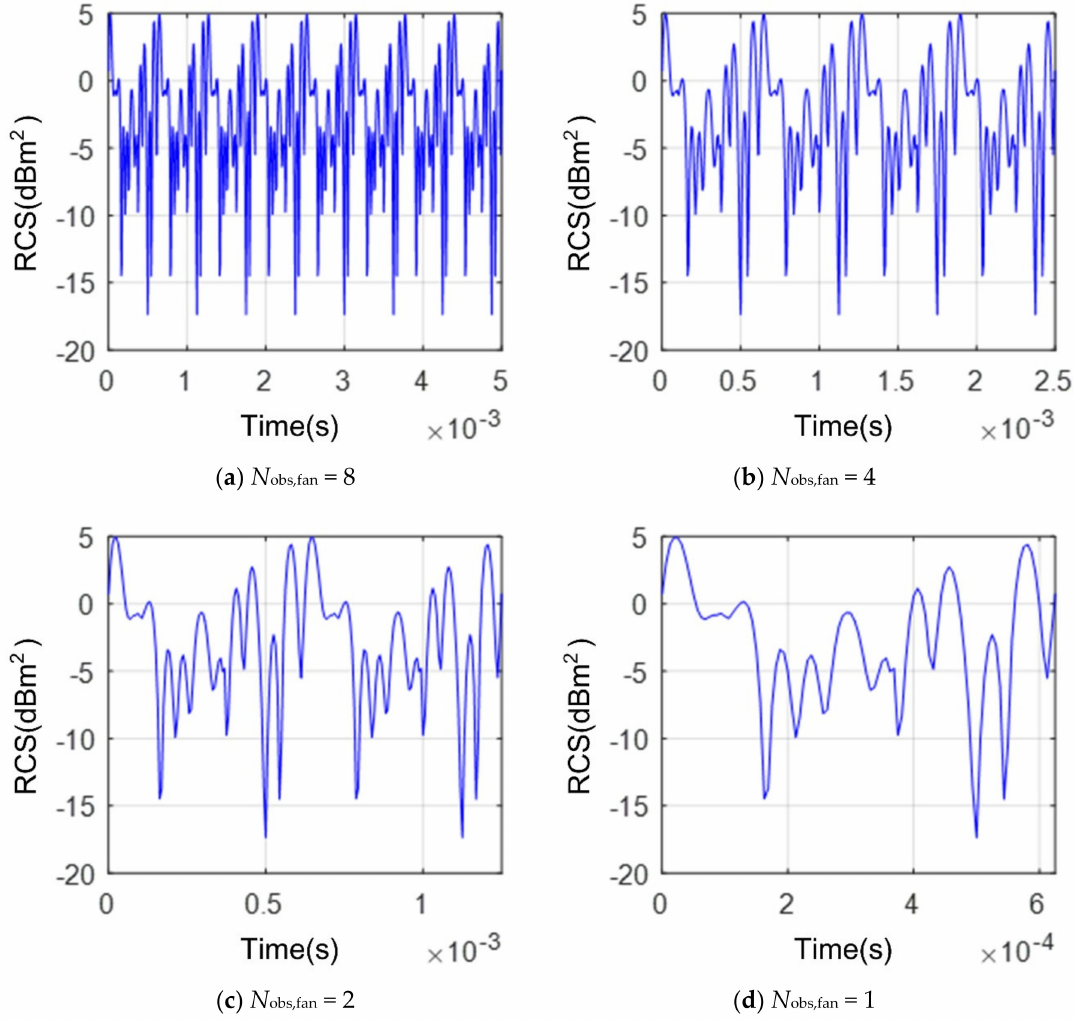
Figure 7. Influence of observation time on dynamic RCS of m fan , α = 20 ◦ and β = 0 ◦